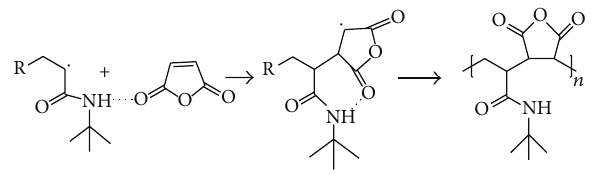
Scheme 2: The effect of H-bonding on copolymerization.